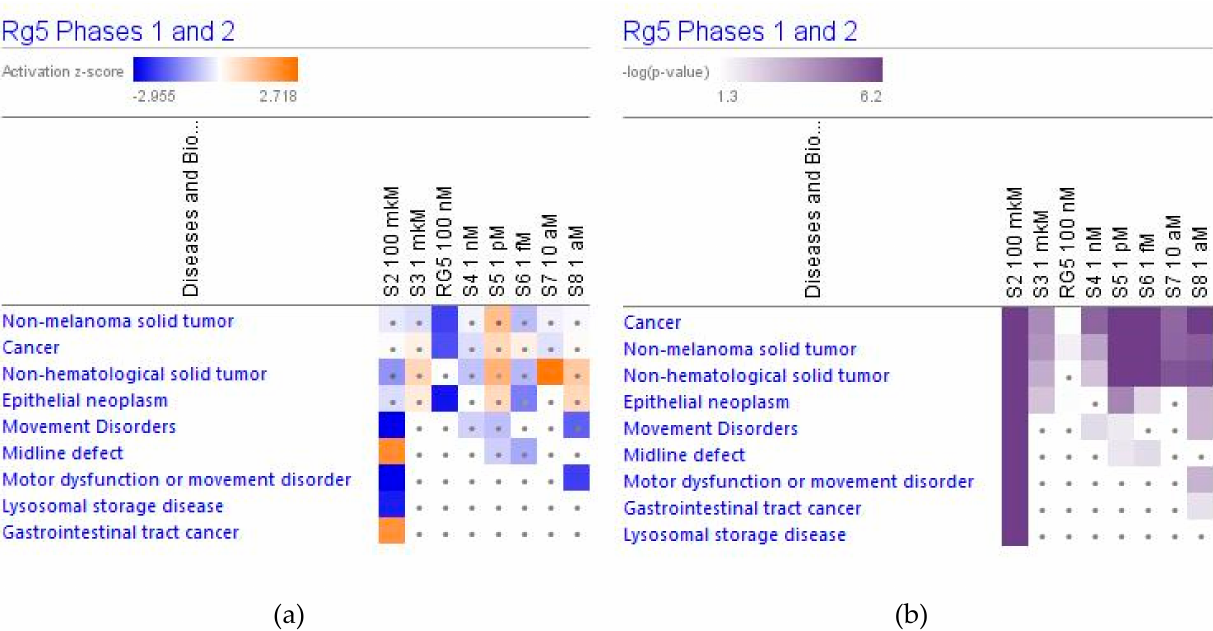
Figure 20. Effect of Rg5 at concentrations of 1 aM, 10 aM, 1 fM, 1 pM, 1 nM, 100 nM *, 1 µ M and 100 µ M) on diseases and disorders, including movement disorders. ( a ) The brown color shows the predicted activation, blue color the predicted inhibition of signaling pathway; the symbol shows that the activation z-score was <2. ( b ) the symbol shows that the − log p -value was <1.3. *: Results from Network Pharmacology of Red Ginseng (Part II).